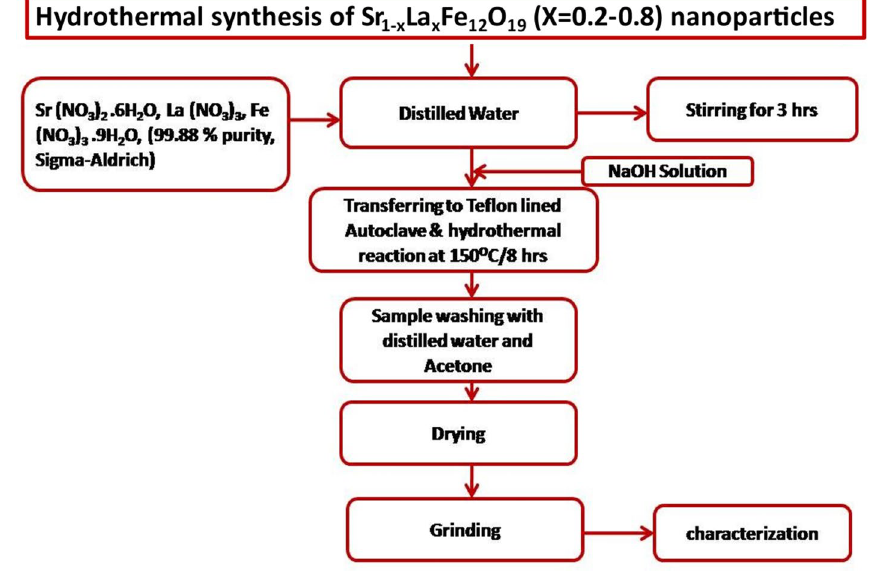
Figure 1. Schematic representation of synthesis of SLFO